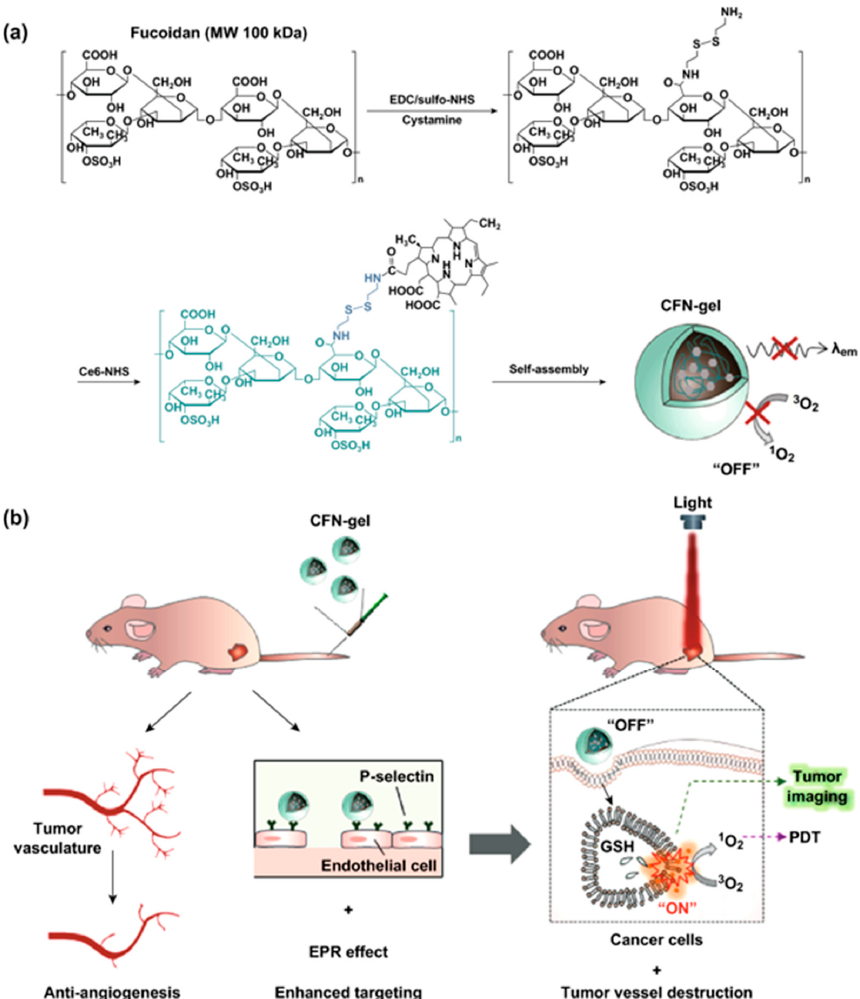
Figure 3. ( a ) Synthesis of the C36–fucoidan theranostic nanogel (CFN-gel). ( b ) schematic illustration of the CFN-gel and its mode of action. EDC: 1-ethyl-3-(3-dimethylamino) propyl carbodiimide; NHS: N-hydroxysuccinimide; GSH: glutathione (reproduced with permission from Cho, M.H.; Li, Y.; Lo, P.C.; Lee, H.R.; Choi, Y. Fucoidan-Based Theranostic Nanogel for Enhancing Imaging and Photodynamic Therapy of Cancer. Nano Micro. Lett. 2020, 12